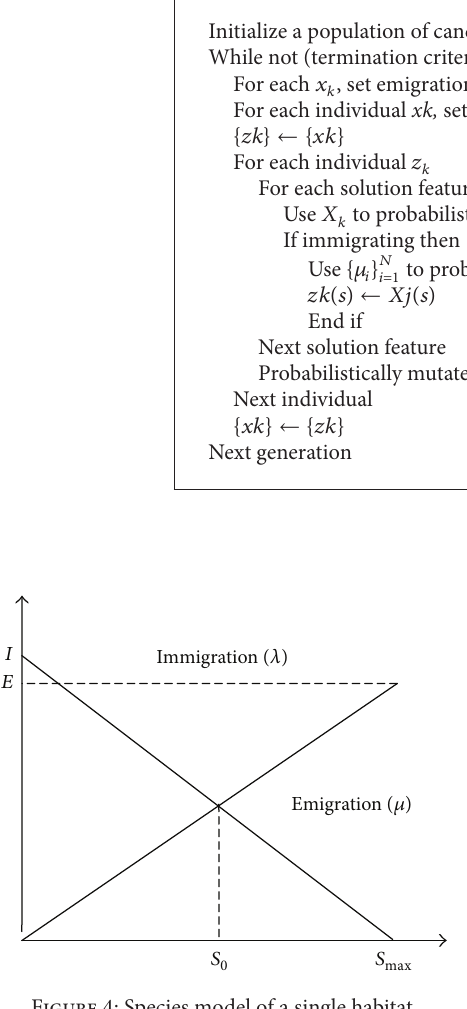
Figure 4: Species model of a single habitat.